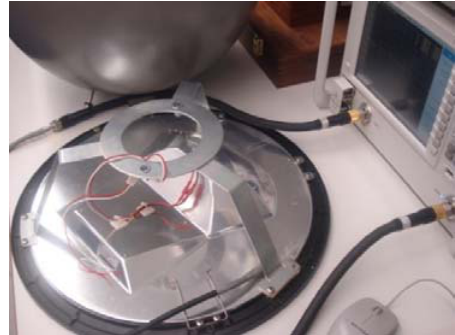
Figure 21. The lamp-post as an antenna showing the radiating elements seen from inside the lamp.